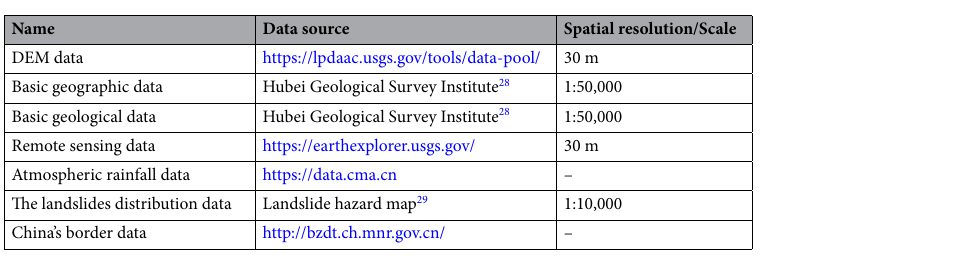
Table 1. Data sources were used in this